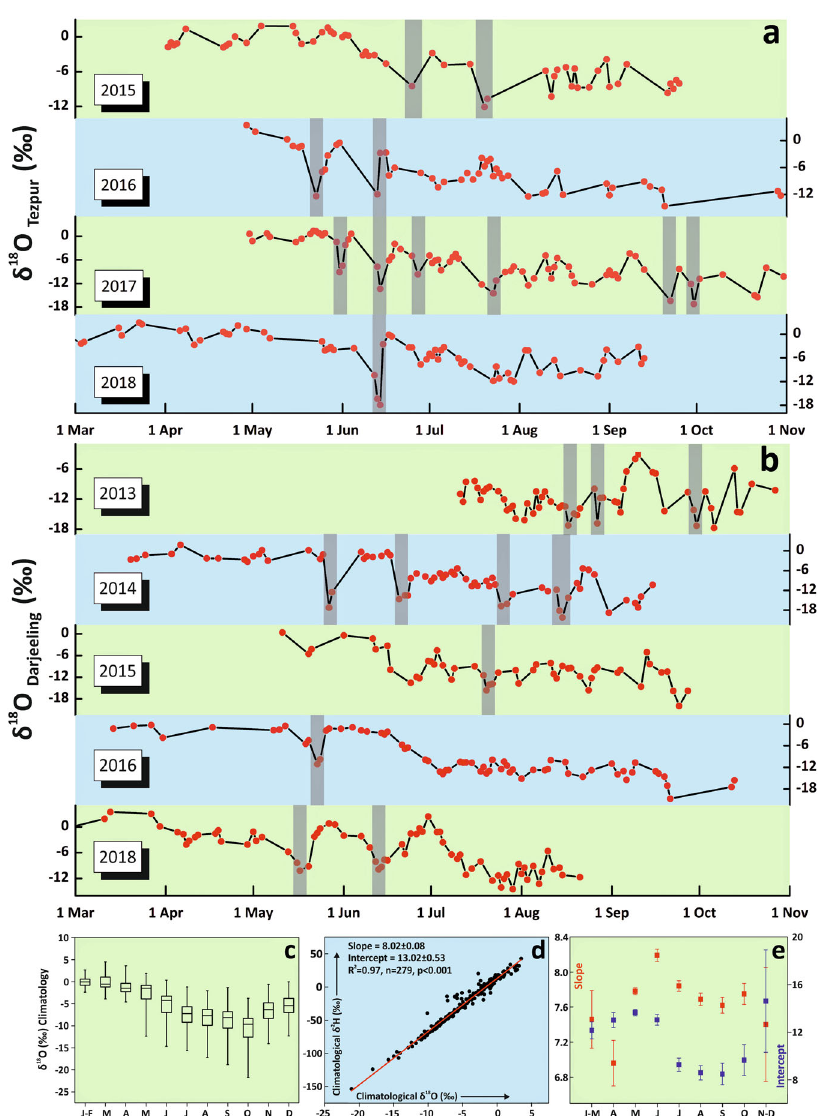
Fig. 2 Precipitation isotope records. Multi-year oxygen isotopic precipitation records for Tezpur ( a ) and Darjeeling site ( b ), respectively. Lower panel c : box plot of the climatological variation of δ 18 O for north-east India; d meteoric water line for NEI. e Monthly variation of NEI meteoric water line slope (red dot) and intercept (blue dot). Error bars indicate standard